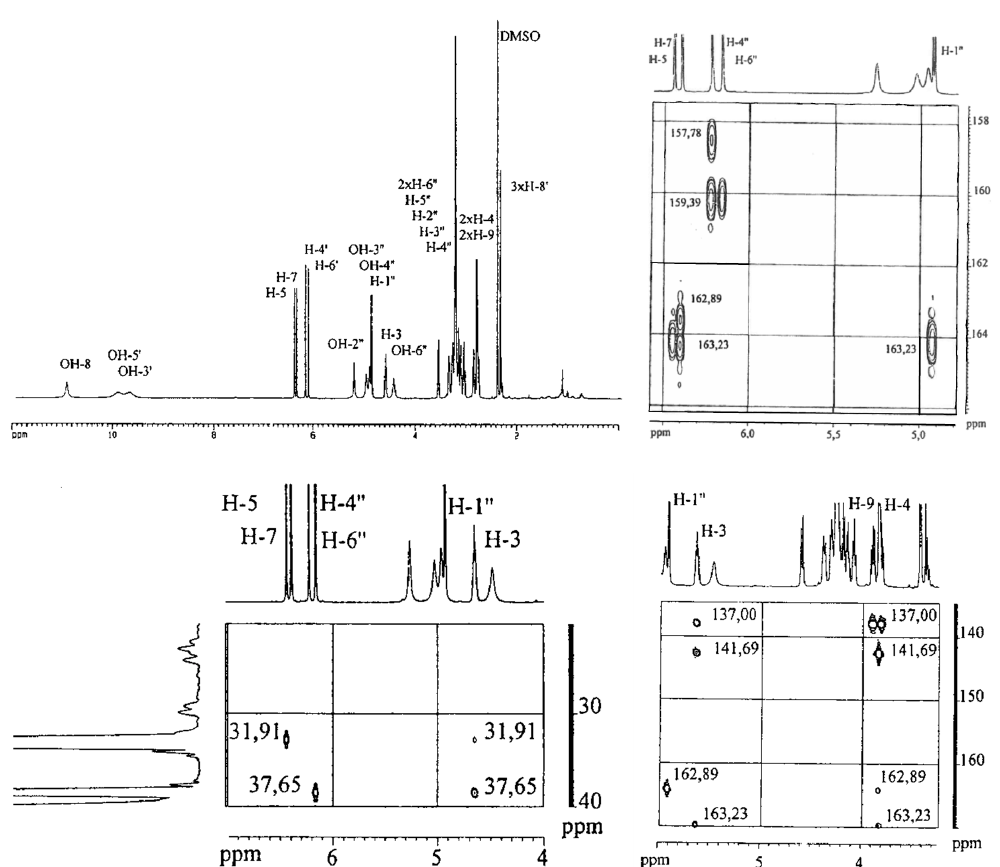
Figure 2. ESI-MS of 6- O - β - D -glucopyranosyl-feralolide ( 3 ). Experimental conditions: see text.